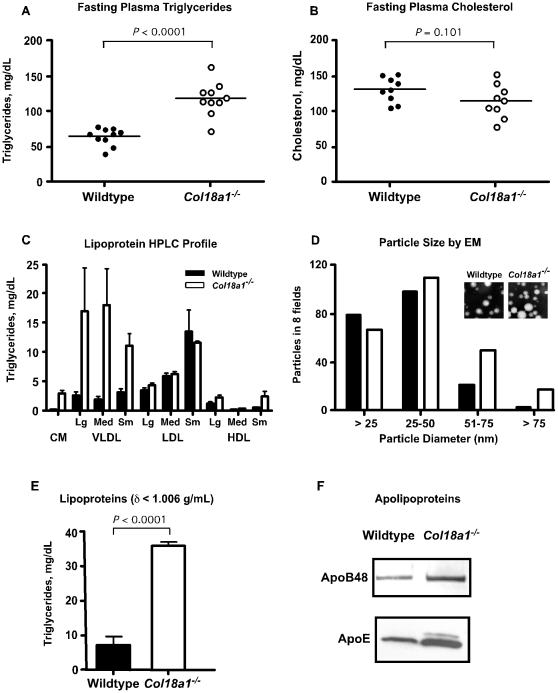
Hypertriglyceridemia in fasted Col18a1−/− mice.(A) Retro-orbital sinus blood was taken from wild-type and Col18a1−/− mice after fasting the animals for 4 hrs in the morning. Total plasma triglycerides were compared between mutant and wild-type (n = 10 mice, unpaired t-test, P<0.0001) and results were repeated. (B) Plasma cholesterol was analyzed in the same samples. (C) Triglyceride distribution across plasma lipoprotein subclasses. Plasma was pooled from 4 mice of each genotype and triglycerides in lipoprotein size classes were determined by LipoSEARCH FPLC. Control mice, filled bars; Col18a1−/− mice, open bars. Chylomicron (CM) >80 nm particle diameter; VLDL, 30–80 nm; LDL, 16–30 nm; and HDL, 8–16 nm. The experiment was performed twice and the error bars represent the range in the recovery of triglycerides in the two experiments. (D) Equal volumes of lipoproteins of δ<1.006 g/ml (pooled from n = 3 mice of each genotype) were analyzed by negative staining transmission electron microscopy (inset, 20,000× magnification, bar = 50 nm). The diameters of particles present in eight fields were analyzed in a blinded fashion. The experiment was repeated twice with comparable results. (E). The fraction of fasting lipoproteins of δ<1.006 g/ml from Col18a1 mutants contained >4-fold more triglyceride than in wild type. The experiment was performed on pooled plasma samples from n = 4 mice and repeated three times. (F) Equal volumes of δ<1.006 g/ml lipoproteins were concentrated by membrane filtration and apolipoproteins were resolved by gradient SDS-PAGE, then visualized by Western blotting with rabbit anti-mouse apolipoprotein B-48/B-100 and apolipoprotein E (apoE) polyclonal antibodies.